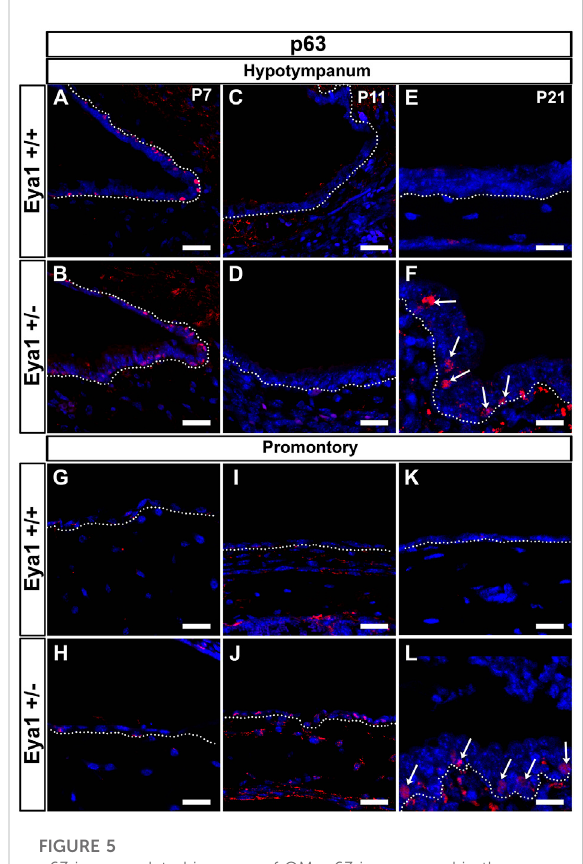
FIGURE 5 p63 is upregulated in cases of OM. p63 is expressed in the epitheliumofthehypotympanum,atP7inWT (A) and Eya1 hets (B) , but it is downregulated at P11 as the epithelium matures (C,D) . In cases of OM, p63 was upregulated in this region [ (F) , arrows] incontrastwiththecontrolsituation (E) .Theepitheliumassociated with the retracting mesenchyme at the promontory region at P7 (G,H) did not show p63 expression, and expression remained off inthe epithelium of thepromontory atlaterstagesin wildtypes (I,K) . Expression was upregulated in the mesenchyme associated epithelium of Eya1 hets at P11 during retraction (J) and in the epithelium of the promontory in cases of OM (L) , correlating with the presence of a hyperplastic strati fi ed epithelium. N numbers: P7n=2 Eya1 +/+,n=3 Eya1 +/ − ;P11n=2 Eya1 +/+,n=2 Eya1 +/ −